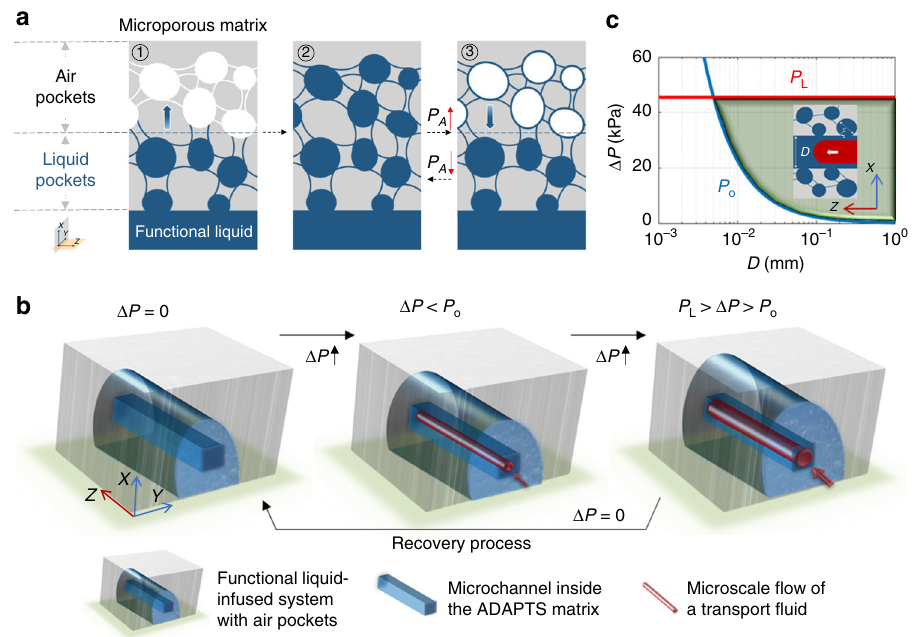
Fig.1 Design of the adaptive air/liquid pocket transport system (ADAPTS). a Schematic of ADAPTS, consisting of a porous matrix partially in fi ltrated with a functional liquid (shown in blue). The distribution of the functional liquid- fi lled pores (liquid pockets) and air- fi lled pores (air pockets) changes with the pressure in the air pocket ( P A ). b ADAPTS guides the microscale fl ow (shown in red) in the square microchannel (shown in dark blue). The transport liquid initiates a fl ow path when the applied pressure ( Δ P ) is beyond a threshold pressure ( P o ) and is con fi ned inside the microchannel under a critical pressure ( P L ). After removal of the pressure, the functional liquid re fi lls the microchannel, and ADAPTS recovers immediately to the original state. c Diagram showing the two critical pressures ( P o , P L ) as a function of the channel size D . The operating range of ADAPTS is marked in light green. The inset shows the invasion of the transport liquid into ADAPTS with average pore size